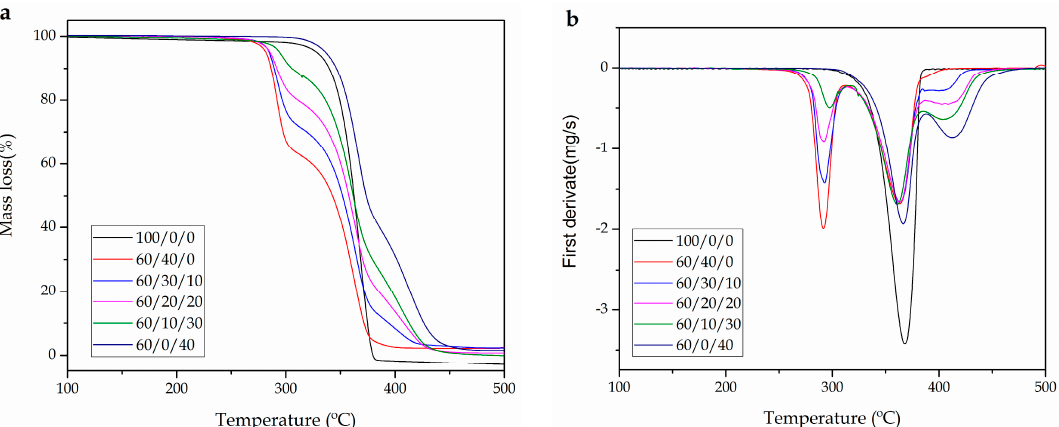
Figure 5. Comparative plot of the thermal degradation of PLA/PHB/PCL ternary blends with different compositions (wt % PLA/wt % PHB/wt % PCL), ( a ) TGA (thermograms), and ( b ) DTG (first derivative curves). Table 3. Thermal degradation properties of PLA/PHB/PCL blends with different compositions (wt % PLA/wt % PHB/wt % PCL) obtained by TGA characterization. PLA/PHB/PCL (wt %)